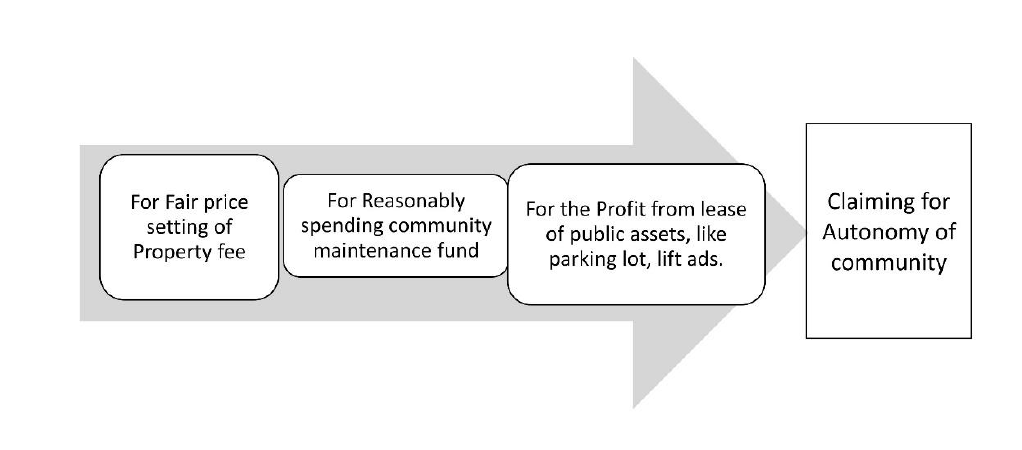
Fig. 10. The homeowners’ strong petition for autonomy (developed by the authors )